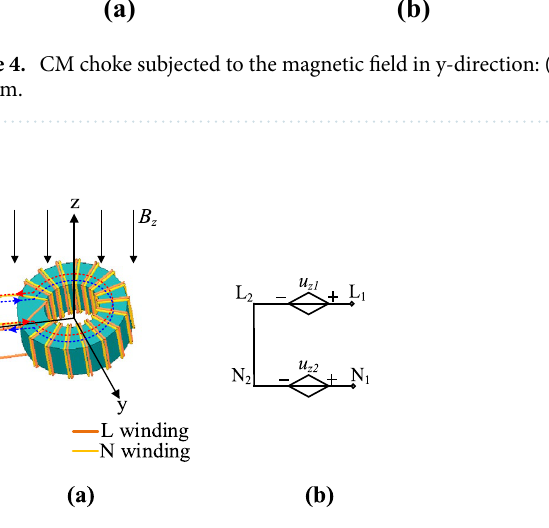
Figure 5. CM choke subjected to the magnetic field in z-direction: ( a ) schematic diagram; ( b ) equivalent circuit diagram.